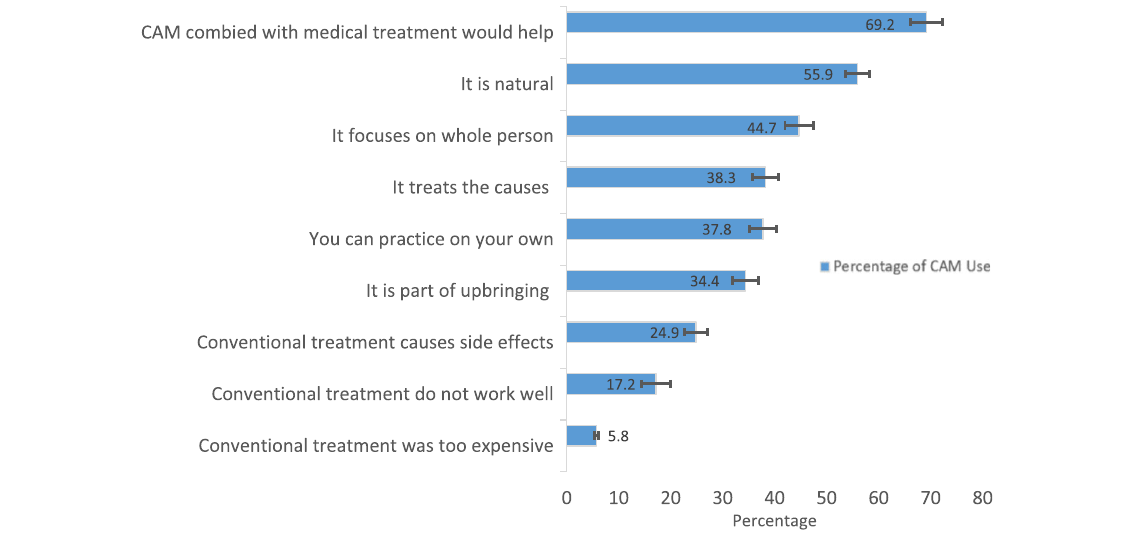
Fig. 4 Reasons for using the top three CAM therapies for children with mental health issues